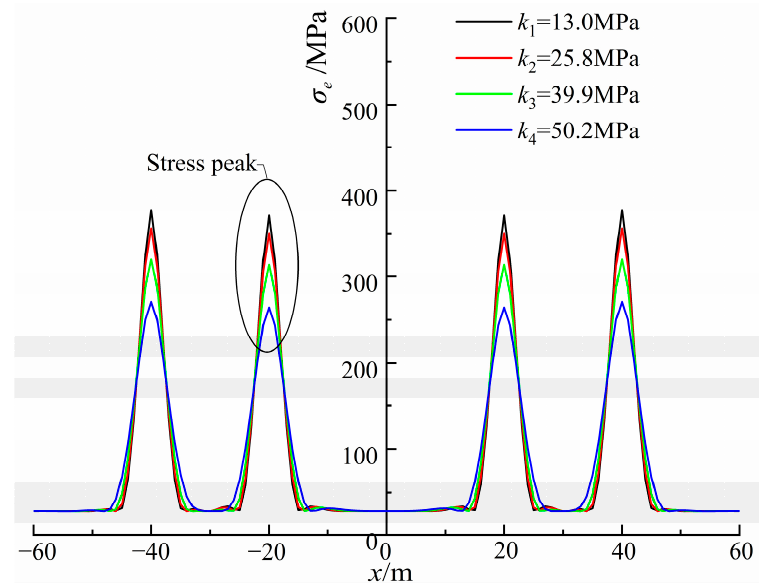
Figure 3. The equivalent stress of pipe under different foundation coefficients.